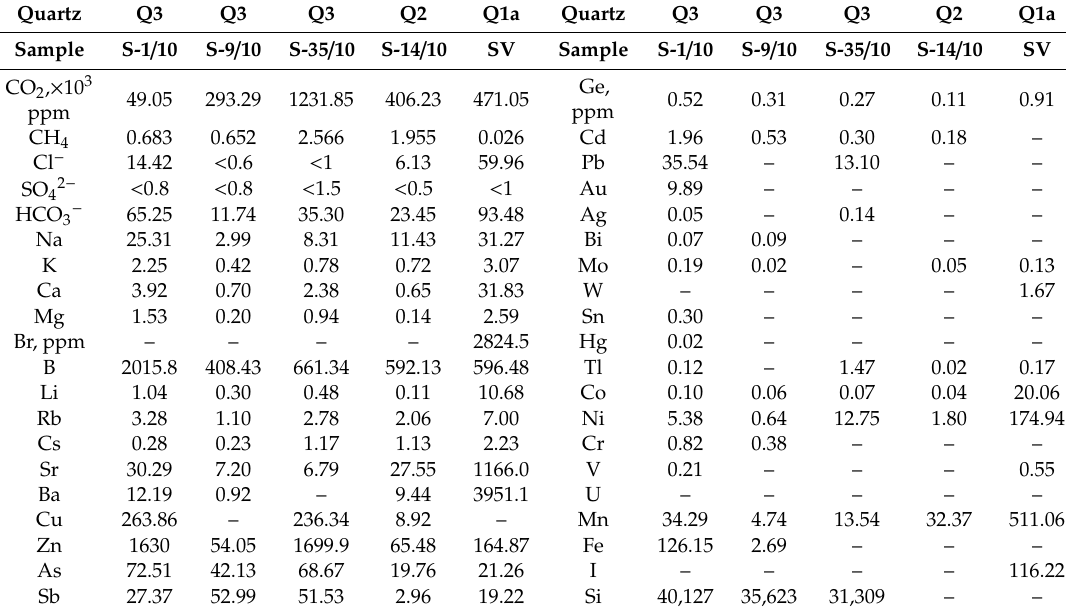
Table 2. Reconstructed fluid compositions according to crush-leach